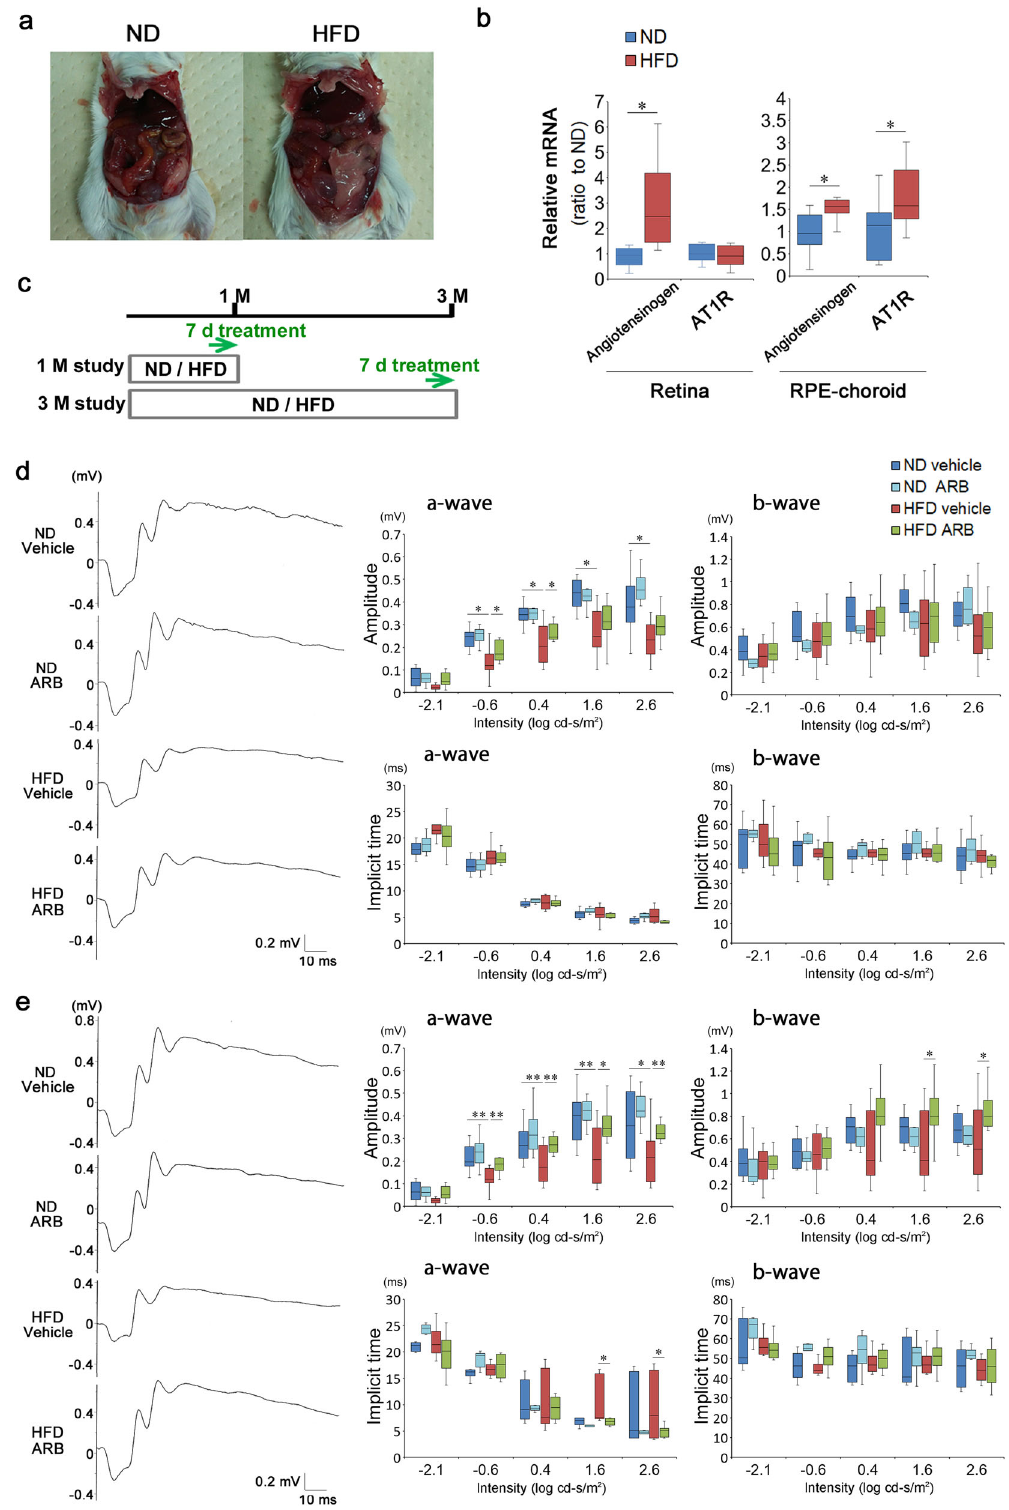
AT1R blockade . We performed a histological analysis to eluci- date the mechanism underlying the photoreceptor disorder induced by HFD, with or without ARB treatment, for 7 days at the end of 1-month HFD intake (Fig. 2a). We found that the photoreceptor OS length was reduced in HFD mice; however, ARB administration preserved the length (Fig. 2a,